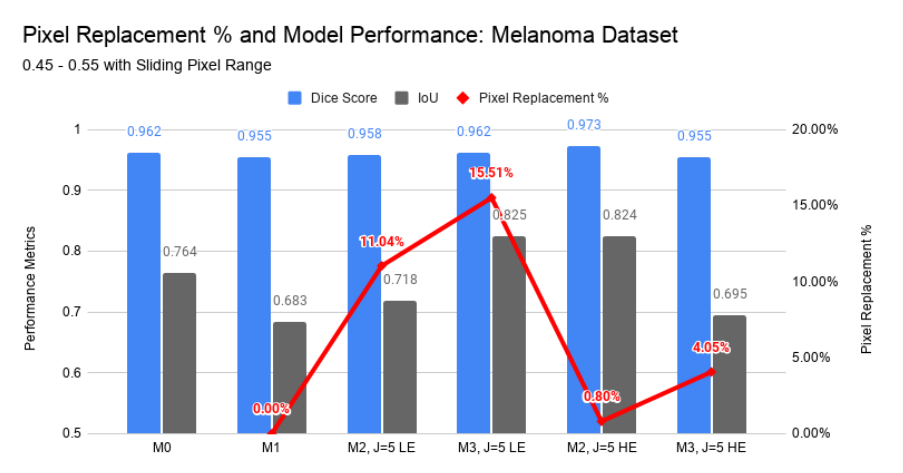
Figure 6. Performance on the melanoma dataset using the SSPA approach with LE and HE pixel label replacements.